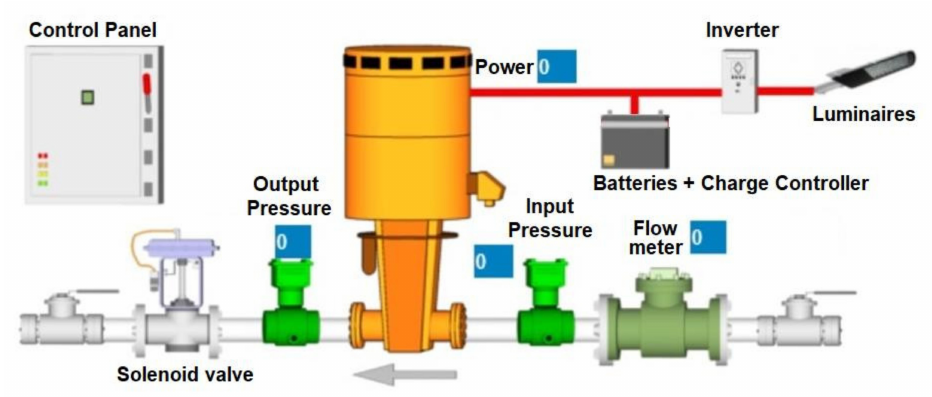
Figure 8. Visual diagram of the energy recovery installation monitoring